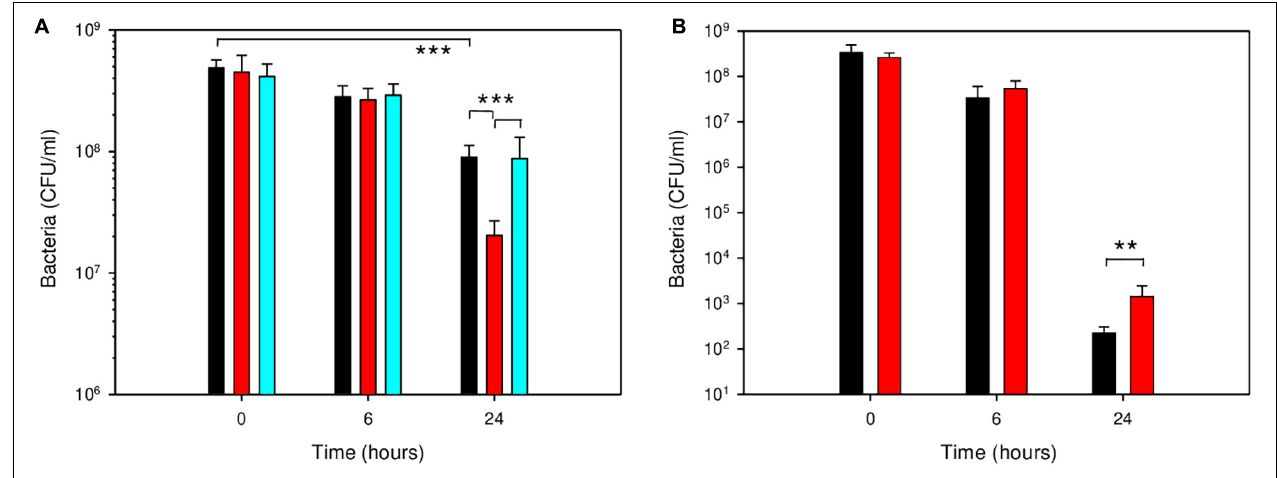
FIGURE 6 | Participation of CspA in survival of B. microti (A) and B. suis (B) in GMM at pH 4.5. Survival of B. microti wild-type strain (black bars), B. microti (cid:49) cspA (red bars), B. microti (cid:49) cspA complemented with pBBR1- cspA (cyan bars), and of B. suis wild-type with pBBR1-AMP (black bars) or complemented with pBBR1-AMP- cspA (red bars) containing functional cspA of B. microti . Values are shown as means of 7 experiments ± SD. **: P < 0.01; ***: P < 0.001.